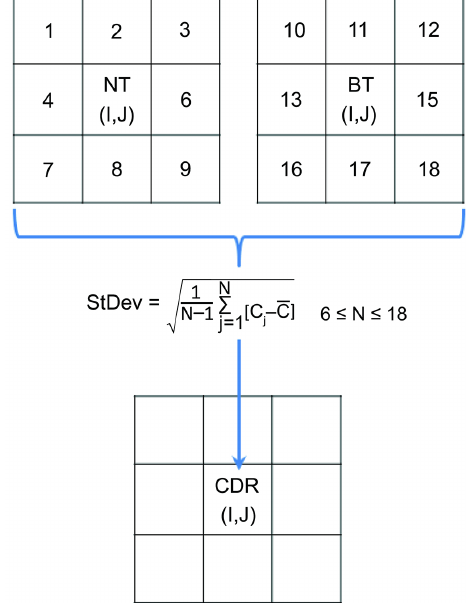
Figure 3. Schematic of grid cell values used in calculation of the CDR standard deviation field. All non-missing ocean / sea ice con- centration values ( C ), from both the NASA Team and Bootstrap algorithm, of the 3 × 3 box surrounding each ( I , J ) grid cell (up to 18 total values) are used to calculate the standard deviation. A min- imum of six grid cells with valid values is used as a threshold for a valid standard